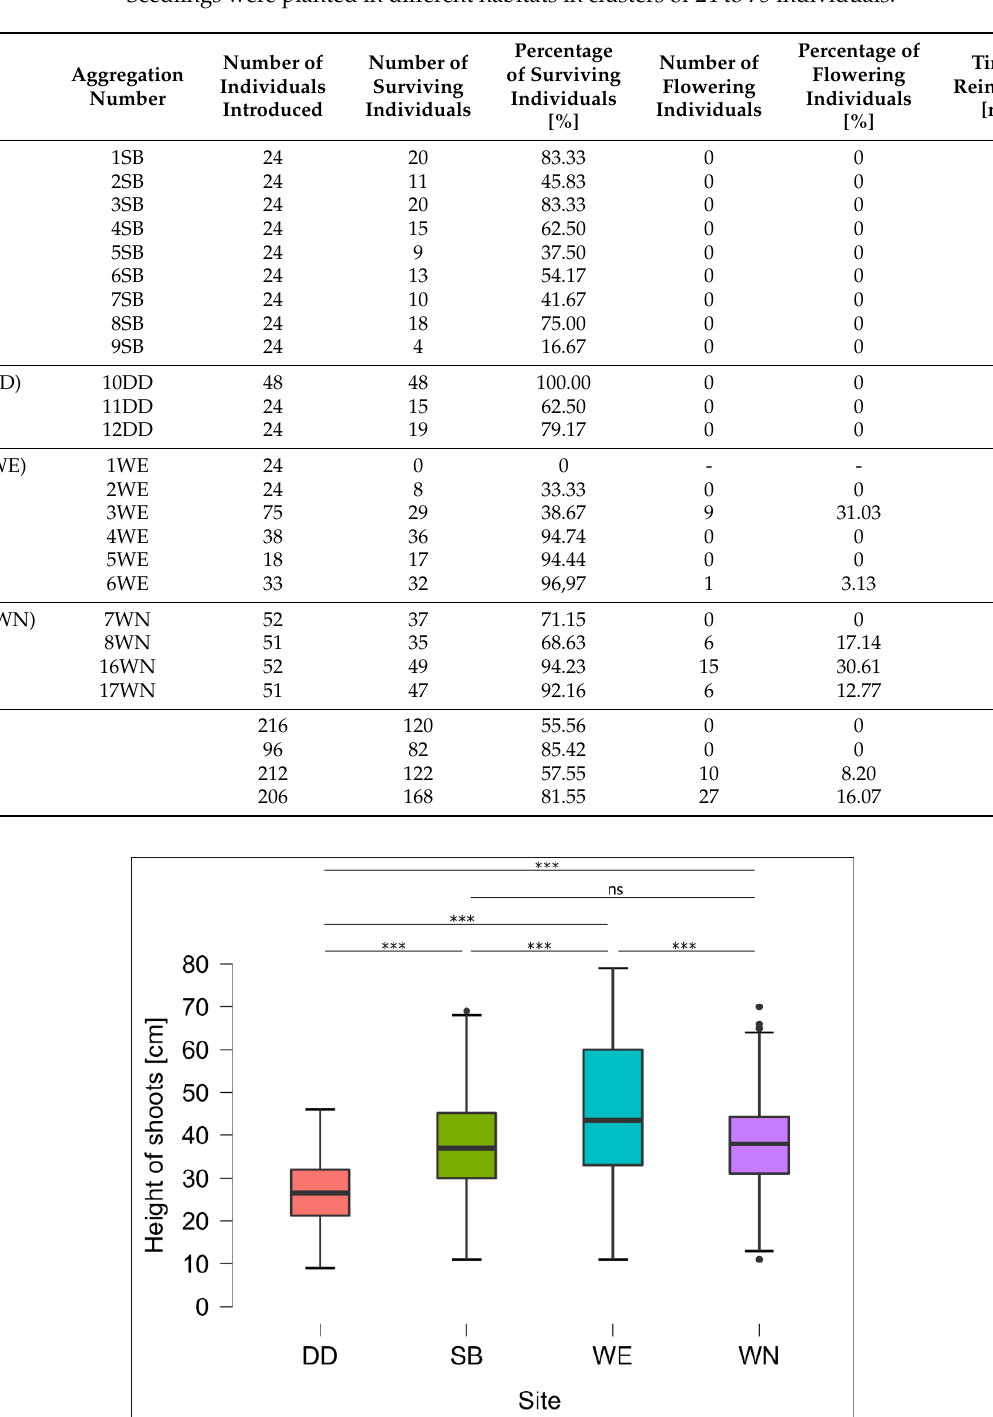
Table 1. The success of Salix lapponum reintroduction performed in 2018–2020 at four sites in the Knyszyn Forest, measured by the number of individuals that survived and produced inflorescences. Seedlings were planted in different habitats in clusters of 24 to 75 individuals.